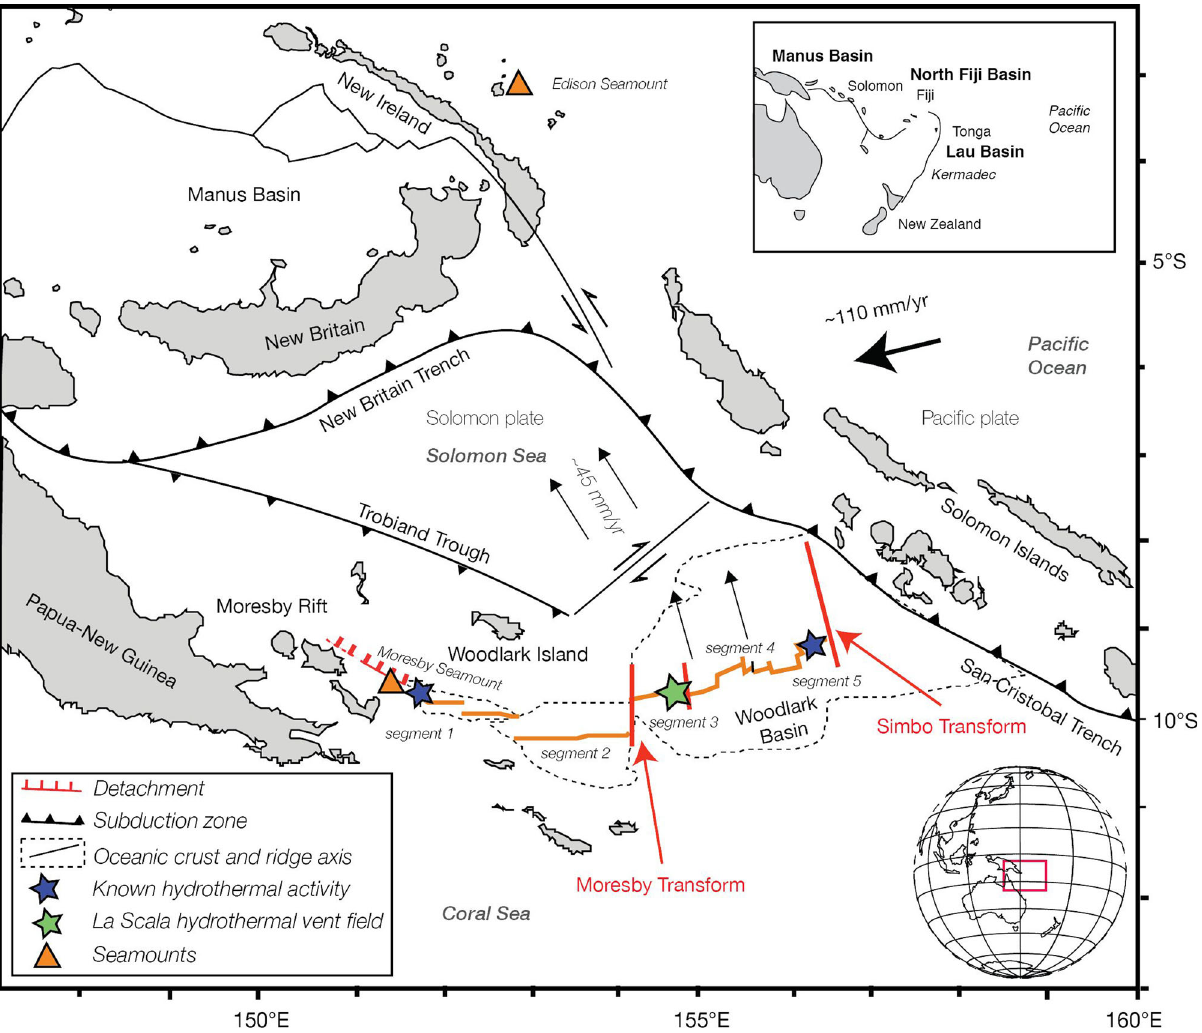
Fig. 1 Regional map of the Woodlark Basin. The main tectonic settings are highlighted as well as the location of the newly discovered ‘ La Scala ’ hydrothermal vent fi eld (green star), modi fi ed from Laurila et al. (2012) 12 . Black arrows indicate the directions of plate motion relative to a fi xed Australian